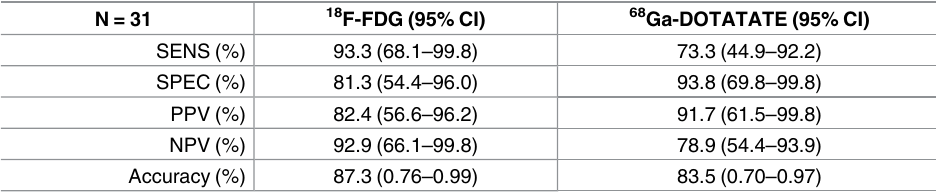
Table 1. Performance comparison of 18 F-FDG and 68 Ga-DOTATATE. N = 31